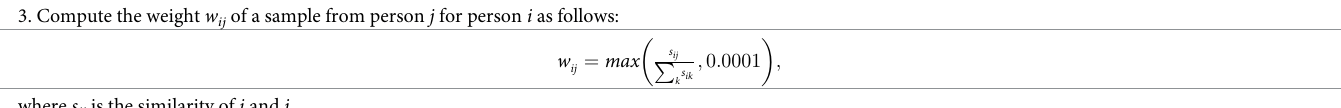
State space. Each session, participants answered ten questions on a 5-point Likert scale.